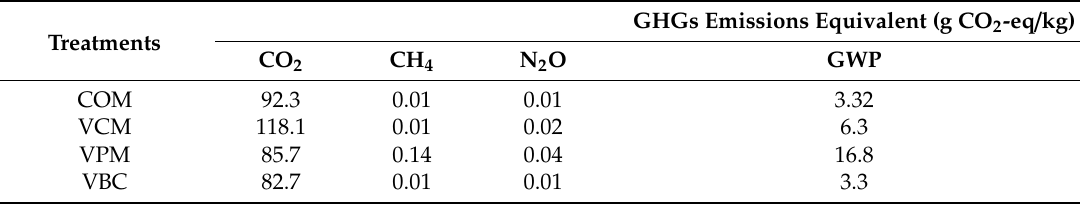
Table 3. Total greenhouse gases (GHG) emissions and global warming potential (GWP) in all treatments.